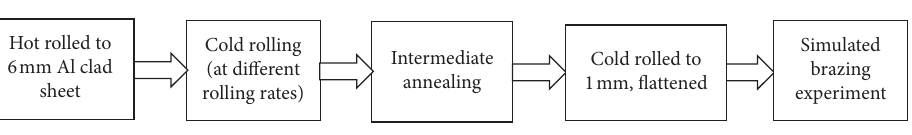
Figure 2: Schematic illustration of brazing